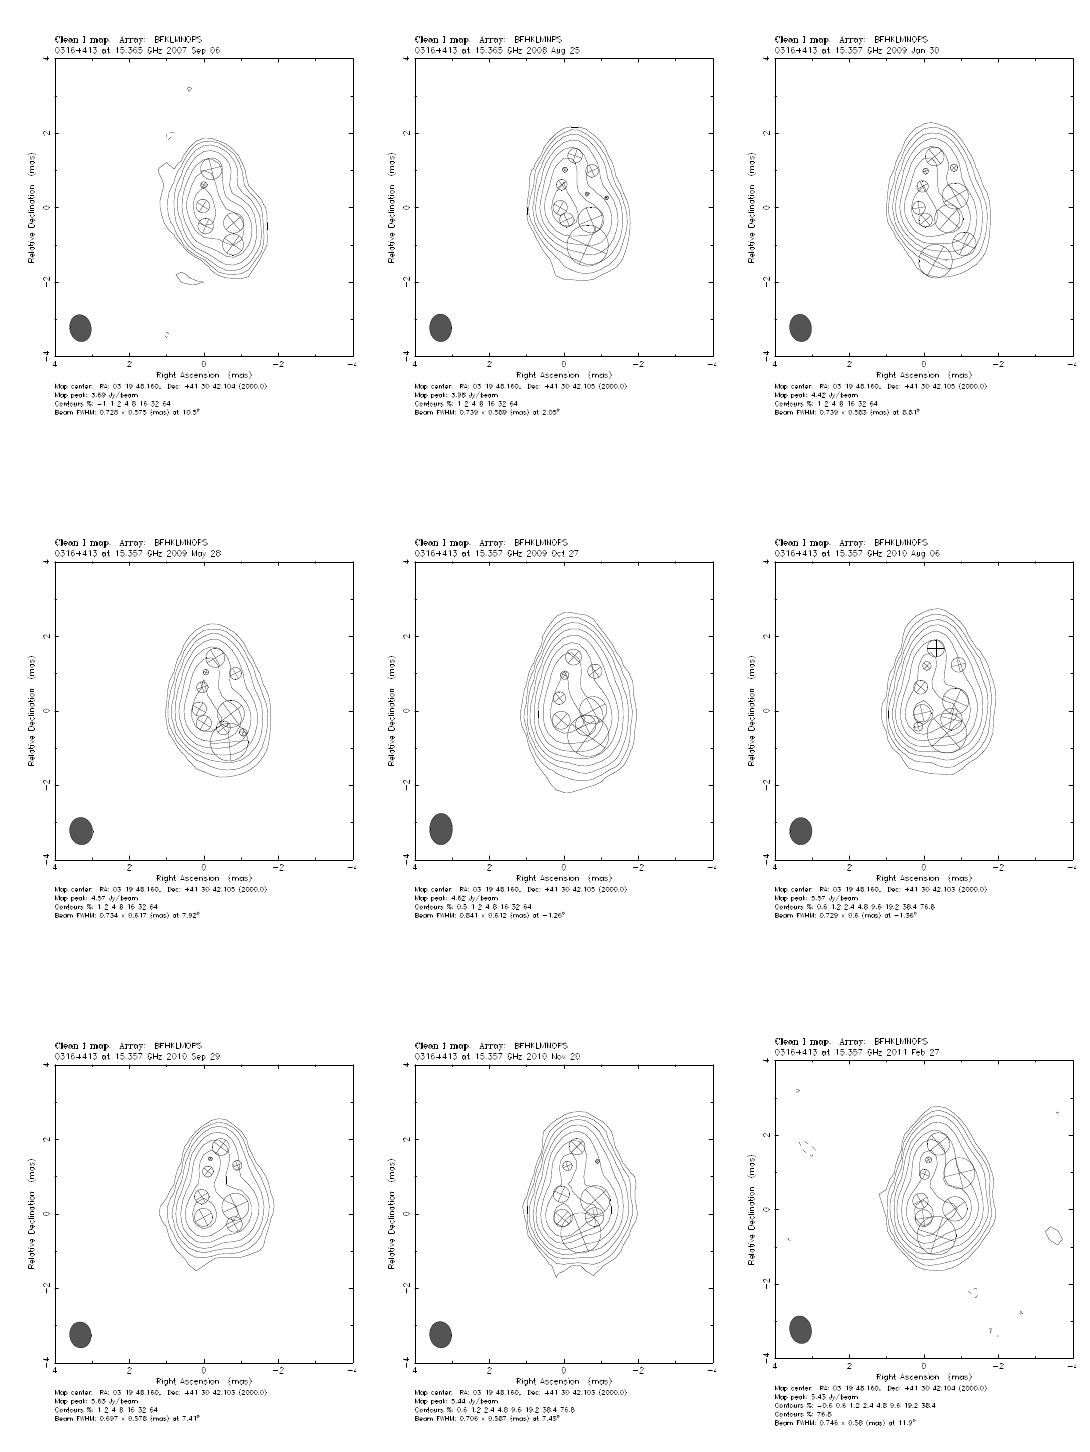
Figure A3. Same as Figures A1 and A2 for epochs: September 2007—February